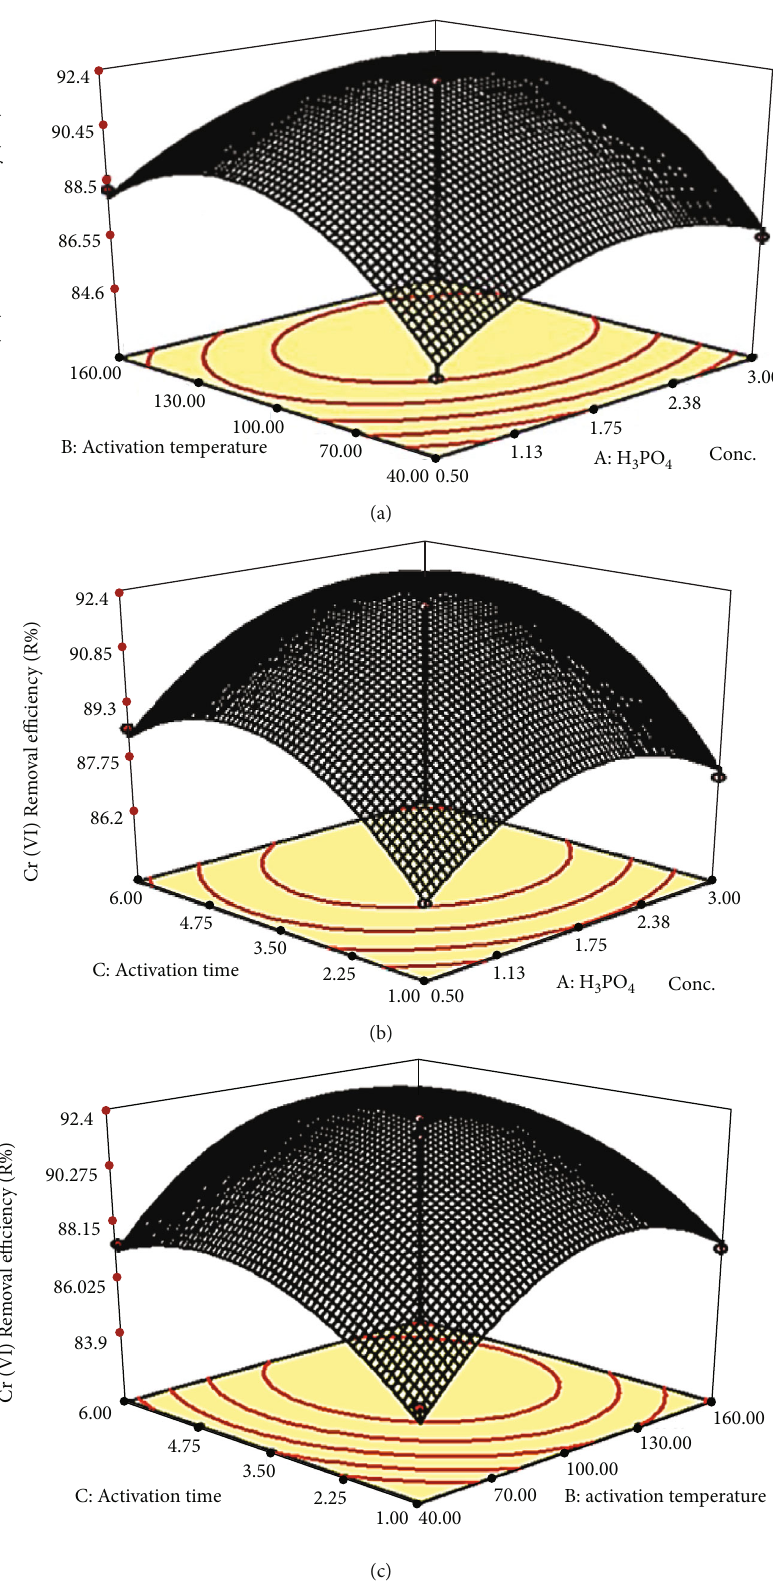
Figure 6: Surface plots of acid-treated Te ff straw biosorbent Cr (VI) removal e ffi ciency. (a) H (b) H PO concentration vs. activation time, and (c) activation temperature vs. activation 3 4